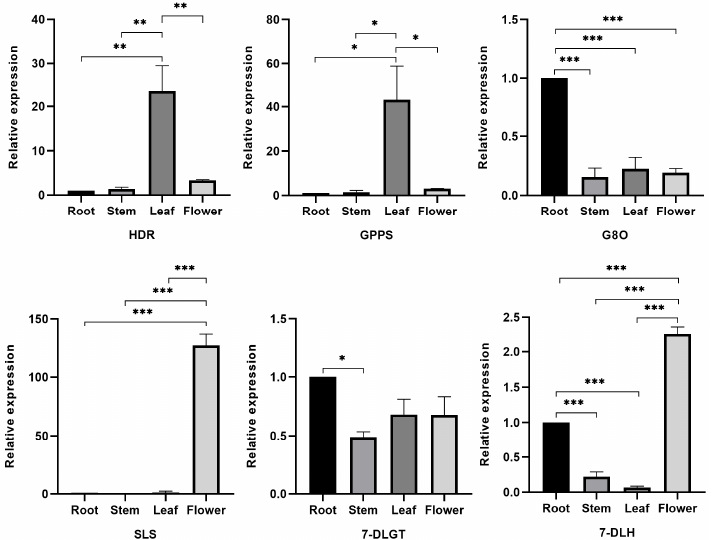
Figure 7. Classification of transcription factor families by analysis of the G. macrophylla transcriptome.